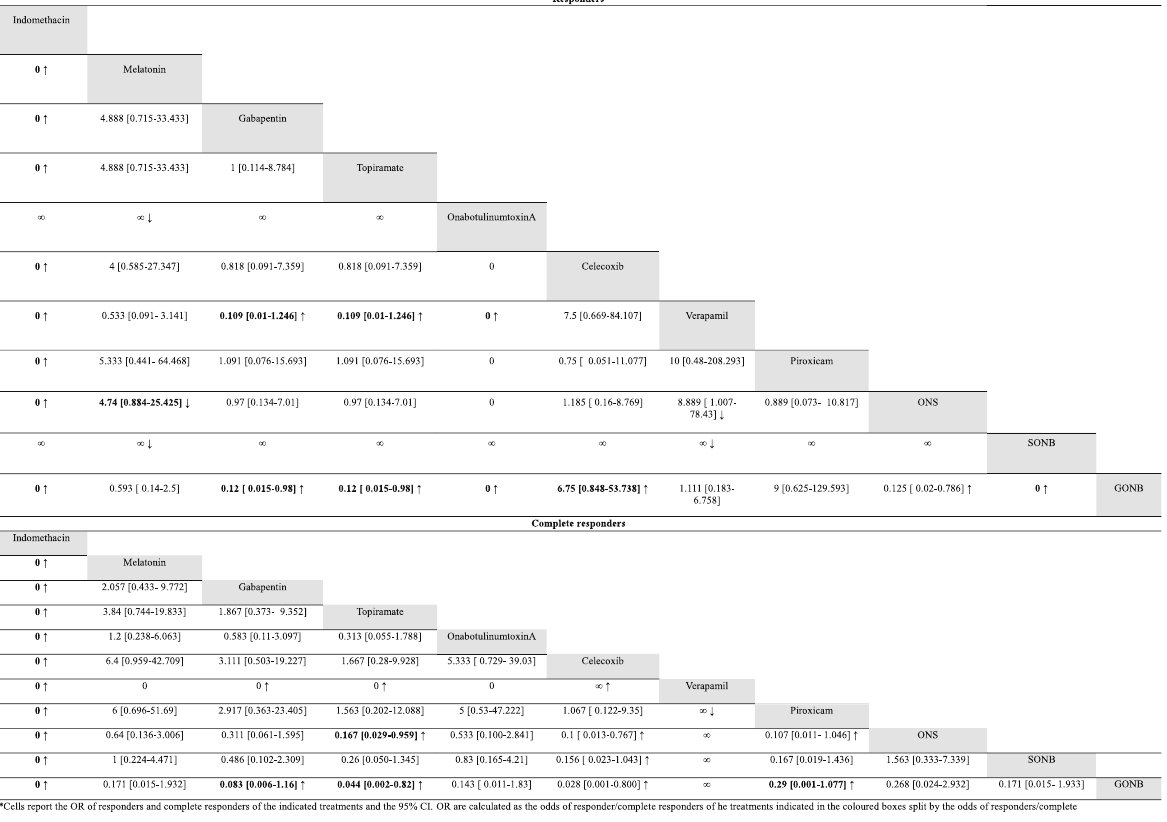
*Cells report the OR of responders and complete responders of the indicated treatments and the 95% CI. OR are calculated as the odds of responder/complete responders of he treatments indicated in the coloured boxes split by the odds of responders/complete responders of the column treatments. The highlighted cells indicate a p -value of the test of equality of odds lower than 0.05. Arrows indicate if the column treatment is better ( ↑ ) or worse ( ↓ ) than the coloured boxes' ones